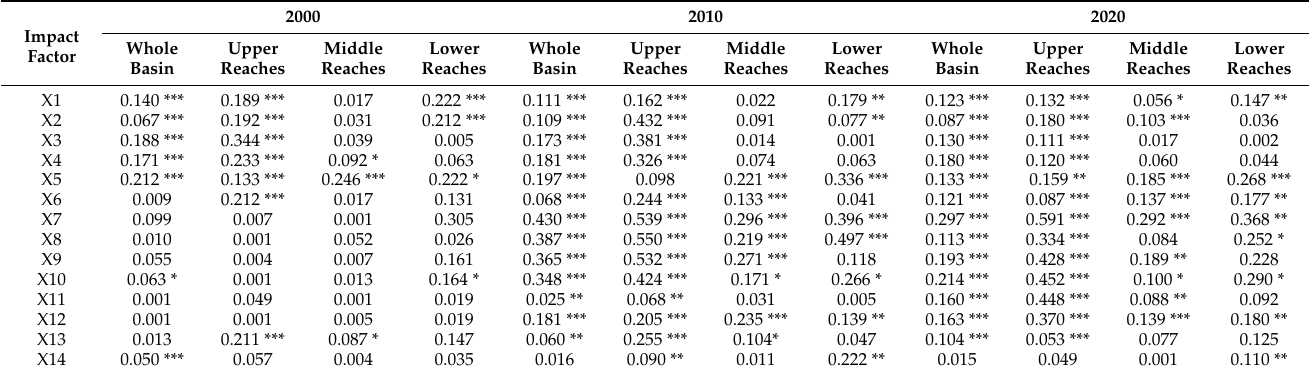
Table 6. Detection factor q for carbon emissions in the YRB from 2000 to